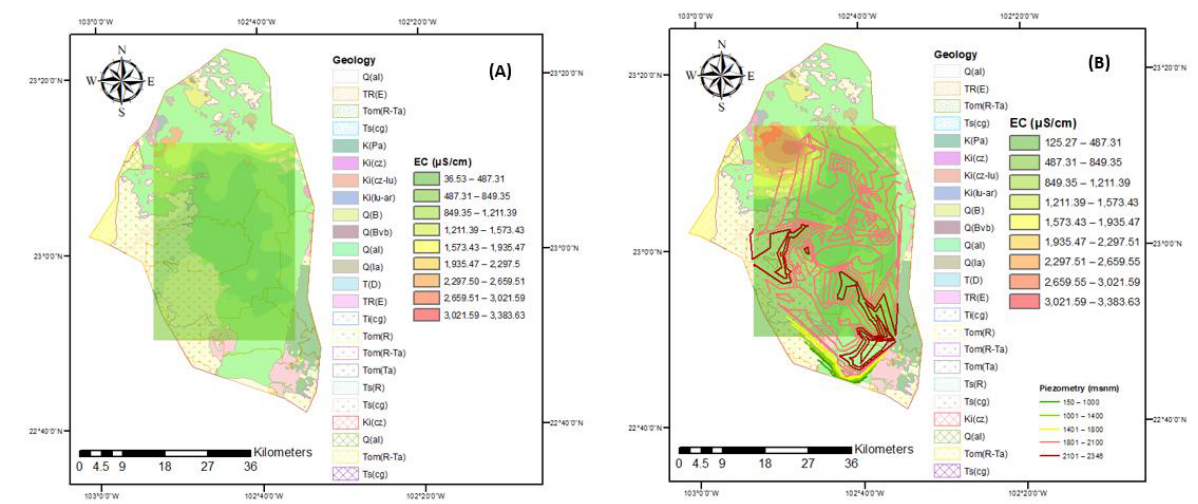
Figure 6. Corresponding EC in the years ( A ) 2005 and ( B ) 2015.